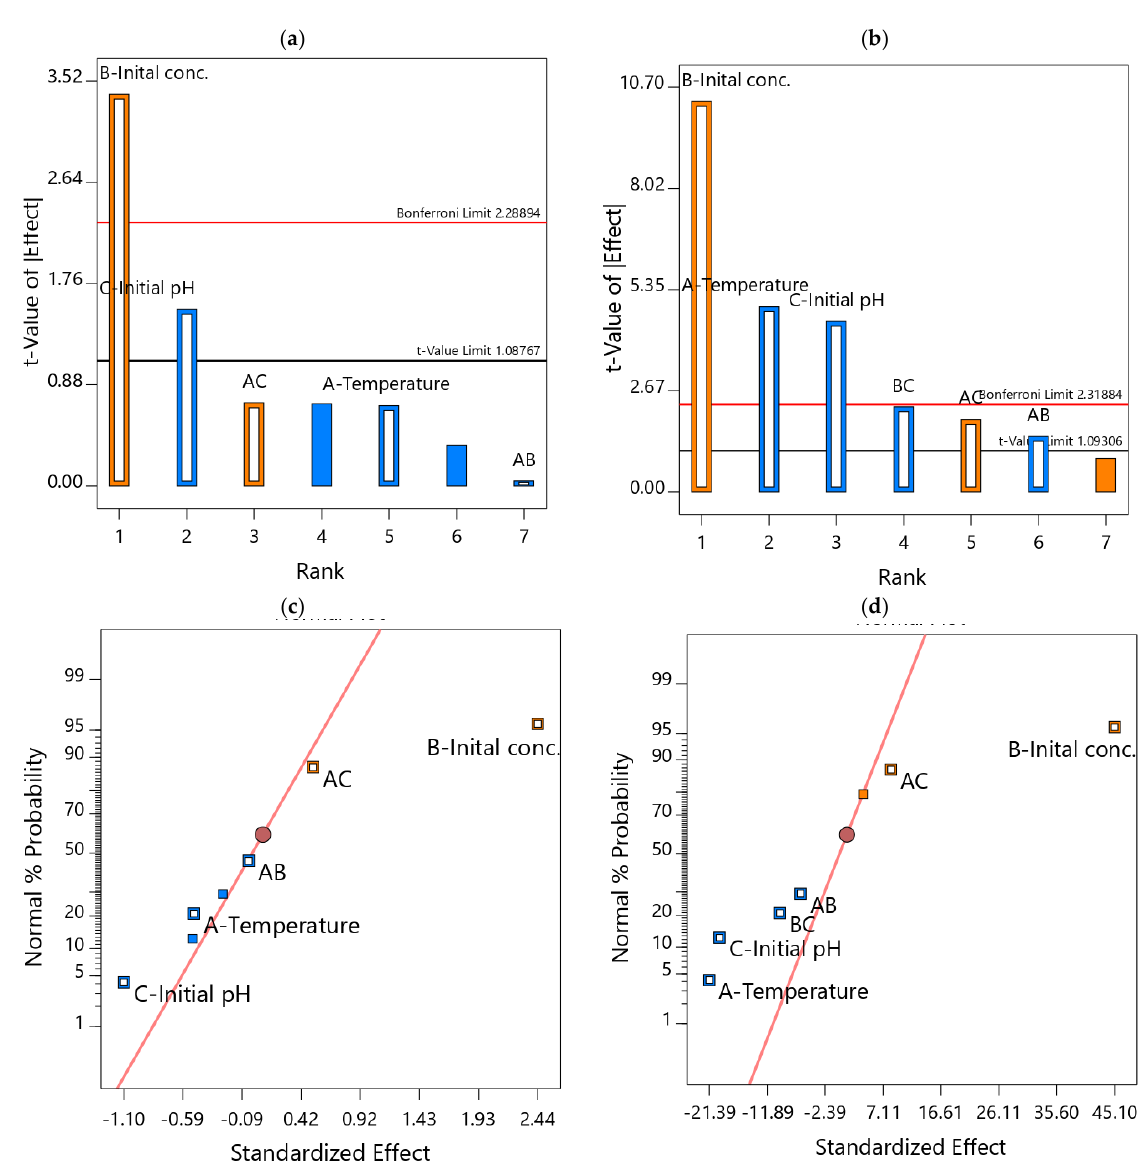
Figure 5. Pareto diagrams ( a , b ) and probability normal plots ( c , d ) the influence of independent variables on Qe1 and Qe2 for Cr(VI) removal from water,